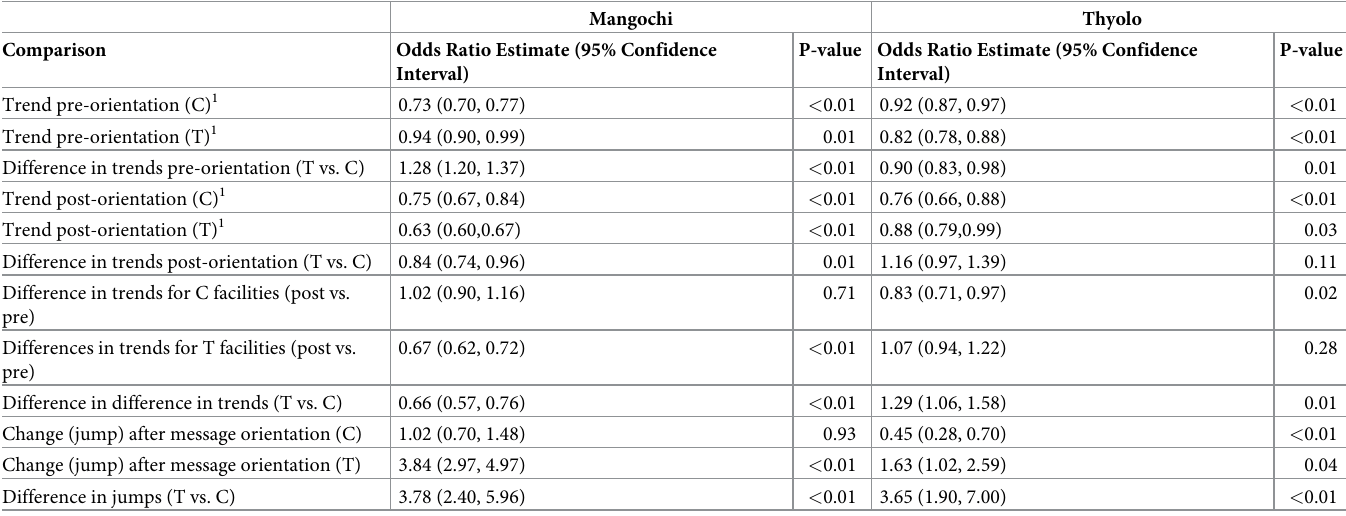
Table 2. Comparisons from model for treatment (T) and control (C) facilities in Mangochi and Thyolo Districts, Malawi.